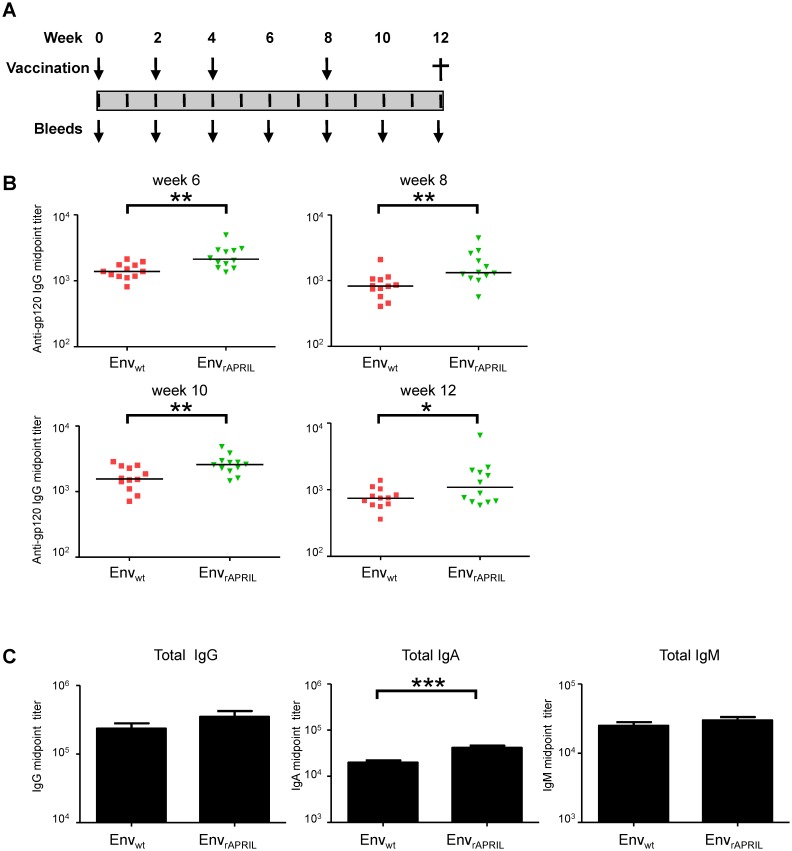
EnvrAPRIL induces an enhanced Env-specific antibody response in rabbits.(A) Immunization scheme. Two groups (n = 12) of rabbits were immunized via gene gun immunization, one group receiving Envwt and the other EnvrAPRIL. (B) Midpoint anti-gp120 IgG titers at week 6, 8, 10 and 12 as determined by ELISA. All sera were tested in duplicate with the mean values shown.*: p<0.05; **: p<0.01 (one-tailed Mann-Whitney test). (C) Total IgG, IgA and IgM midpoint titers in week 10 sera of rabbits immunized with Envwt and EnvAPRIL.